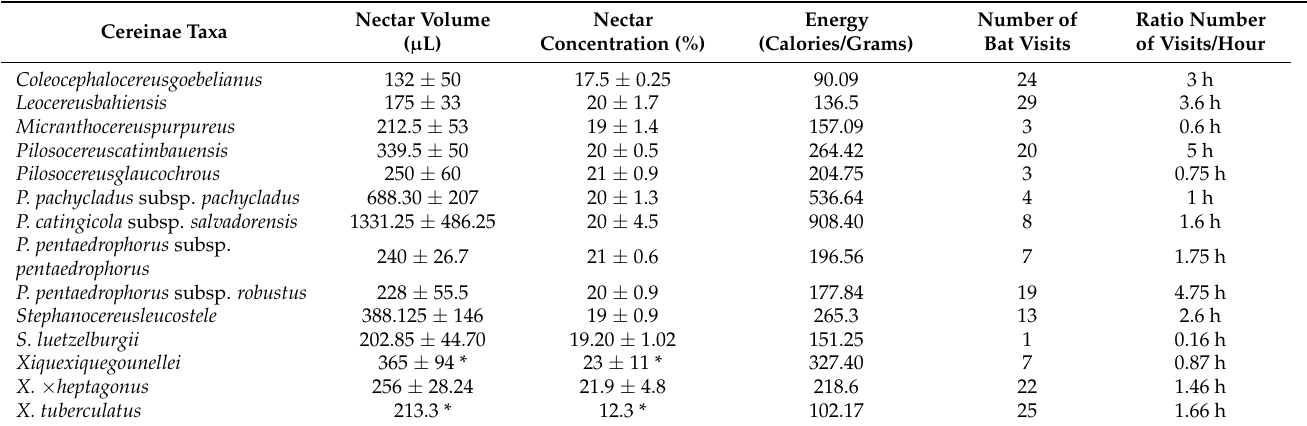
Table 6. Volume, concentration, and energy of standing crop nectar of Cereinae (Cactaceae) taxa pollinated by bats. Number of visits by bats to flowers of each